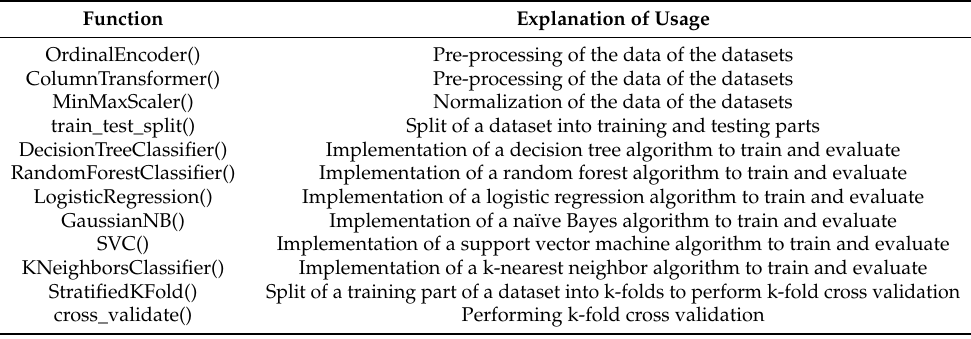
Table 8. Utilized functions of the Scikit-Learn package, along with a brief explanation of how they were